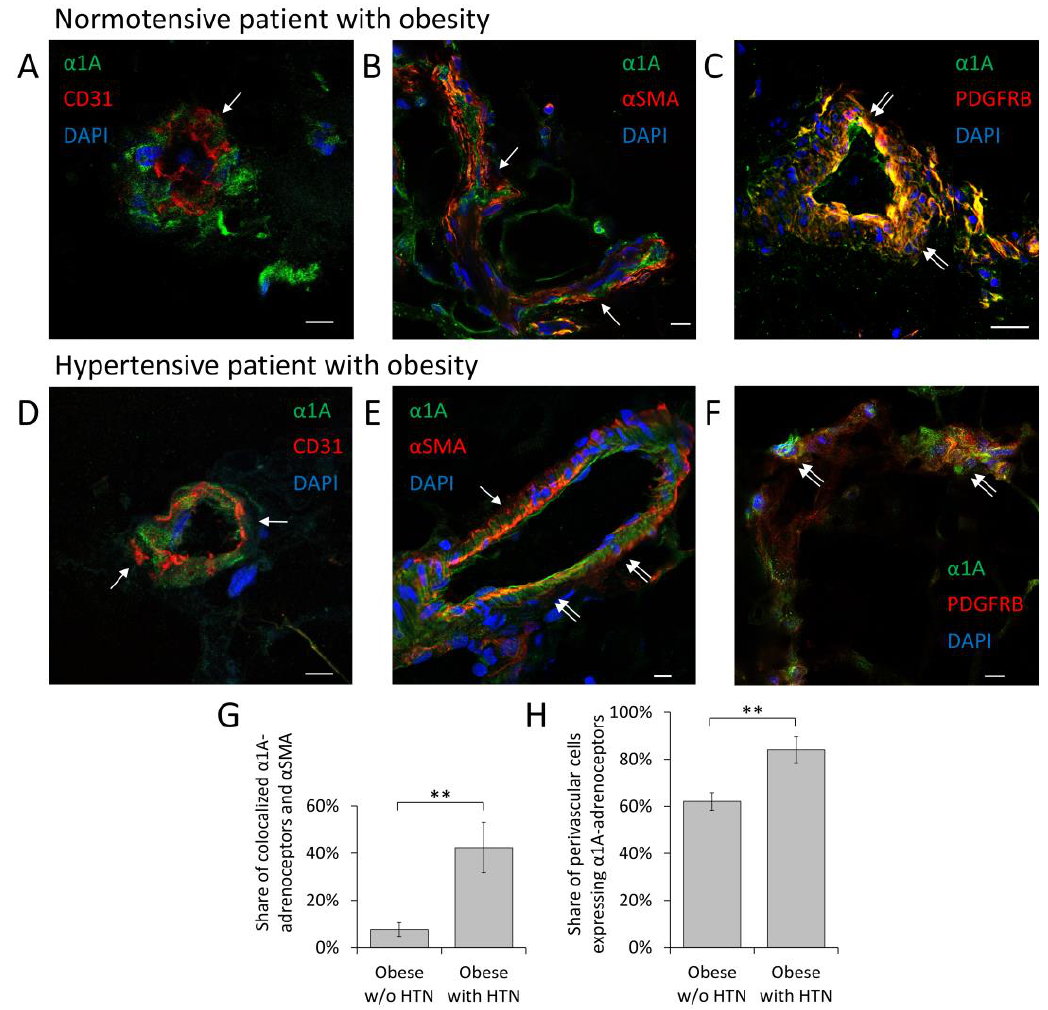
Figure 1. Alpha1A-adrenoceptor expressing MSCs have perivascular distribution. ( A – F ) Confo- cal images of frozen sections of human subcutaneous adipose tissue. ( A – C ) Adipose tissue of normotensive patients with obesity. ( D – F ) Adipose tissue of hypertensive patients with obesity. ( A , D ) Alpha1A-adrenoceptor (green) is localized outside of CD31 positive endothelial cells (red, single arrow). ( B ) Alpha1A-adrenoceptor (green) is localized outside of alpha-smooth muscle actin positive cells (red, single arrow). ( E ) Alpha1A-adrenoceptor (green) is localized in the portion of alpha-smooth muscle actin positive cells (yellow, double arrow). ( C , F ) Alpha1A-adrenoceptor (green) is localized in MSCs (PDGFR β —green) (yellow, double arrow). Nuclei stained with Dapi (blue). Scale bar 10 µ m. ( G ) In hypertensive patients with obesity, alpha1A-adrenoceptor colocalizes with alpha-smooth muscle actin in some perivascular cells. Share of perivascular cells with alpha1A- adrenoceptor and alpha-smooth muscle actin colocalization calculated based on immunofluores- cent staining. ( H ) Percentage of perivascular cells expressing alpha1A-adrenoceptor in normotensive patients with obesity and hypertensive patients with obesity. Mean ± SEM, n = 8–23, ** p < 0.01 (Mann–Whitney U